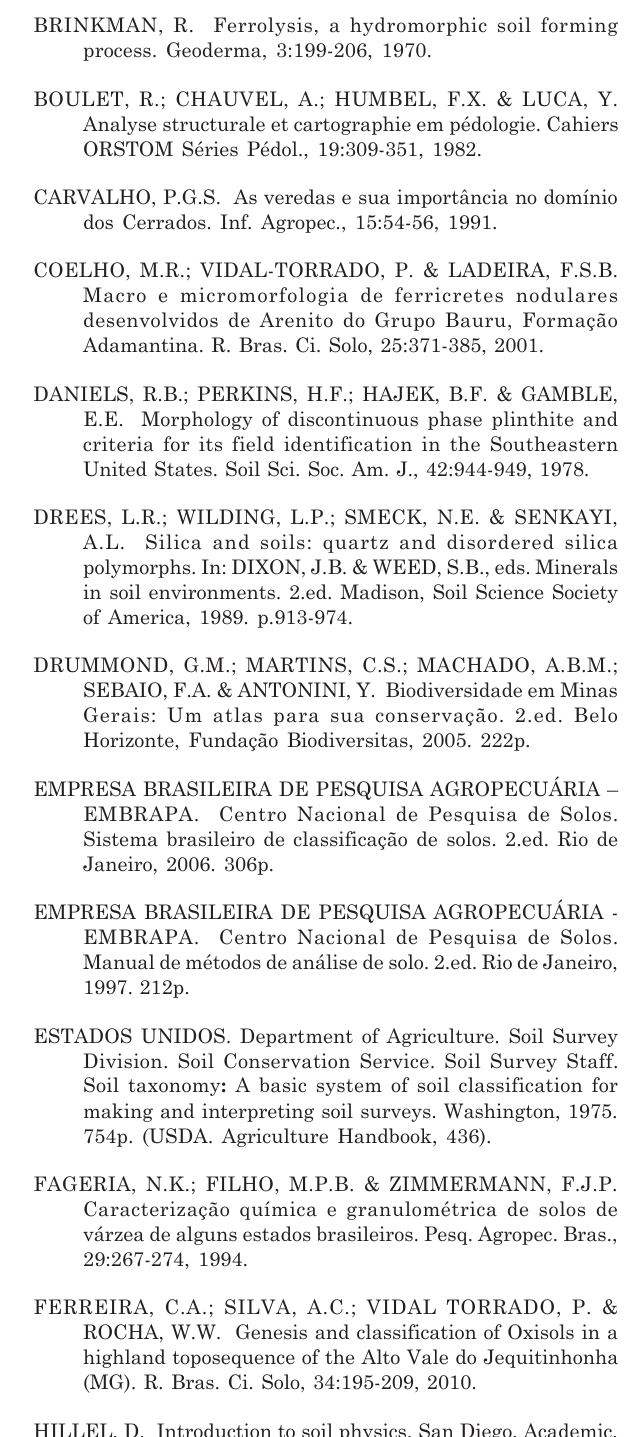
(Figure 3). Based on the Soil Taxonomy (EUA, 1975), the same soil profiles were classified respectively as: Typic Haplustox (LVA), Xanthic Haplustox (LA), Xanthic Haplustox gray color, here called “Gray Haplustox” (“LAC”) and Typic Albaquult